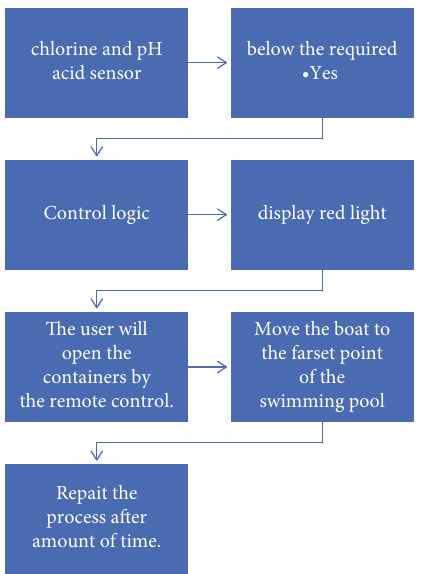
Figure 12: The process of the water